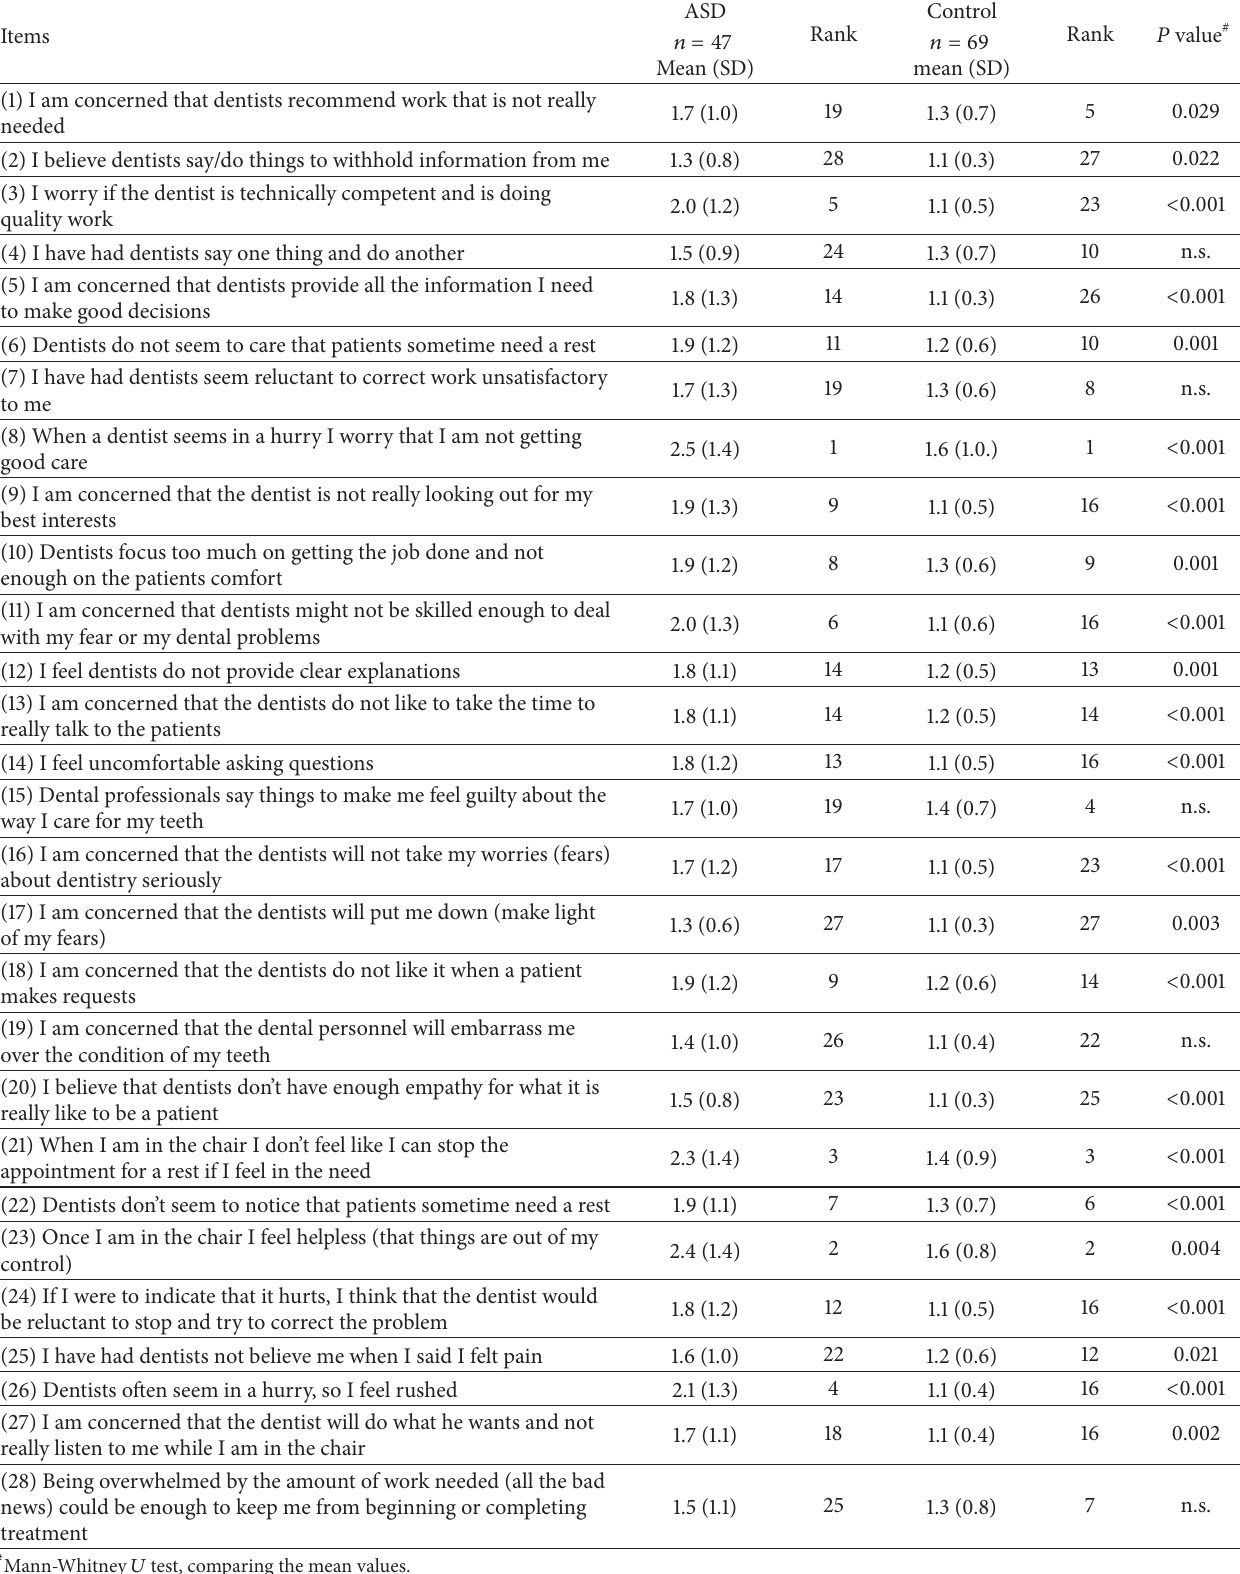
Table 5: Item mean scores and ranking of Dental Beliefs Survey (DBS-R) in autism spectrum disorder (ASD) and